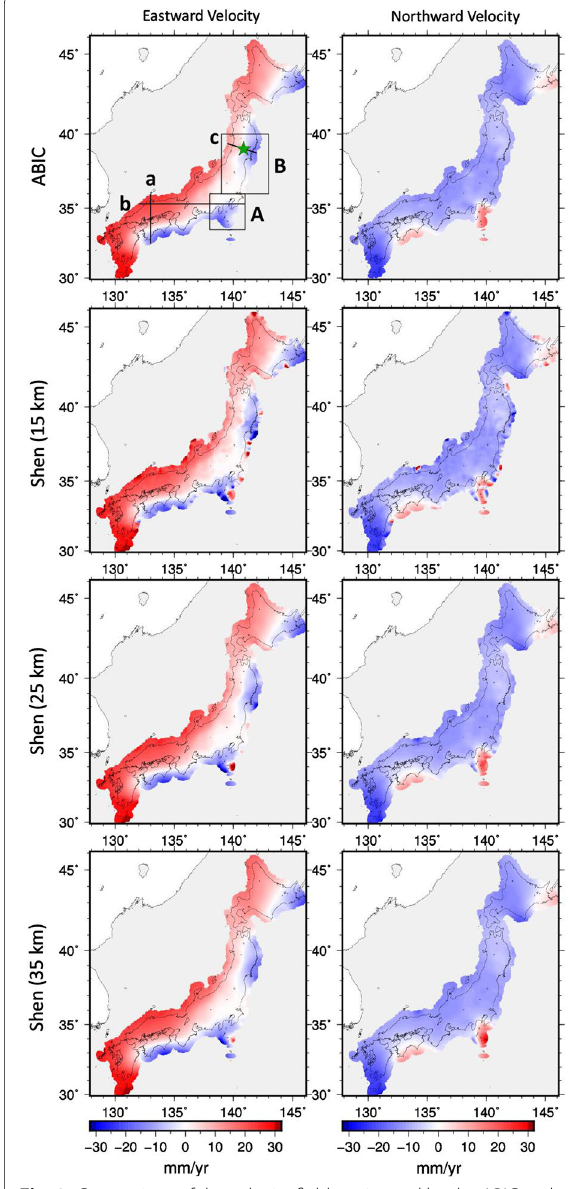
Fig. 2 Comparison of the velocity fields estimated by the ABIC and Shen’s methods. Results of different values of the distance decaying constant ( D 15, 25, and 35 km) are presented for Shen’s method. = Boxes A and B indicate the area shown in Figs. 3 and 5, respectively. Three black lines (a, b and c) show cross sections presented in Figs. 6 and 9. The green star represents the epicenter of the 2008 Iwate-Miyagi inland earthquake, which is also shown in Fig.